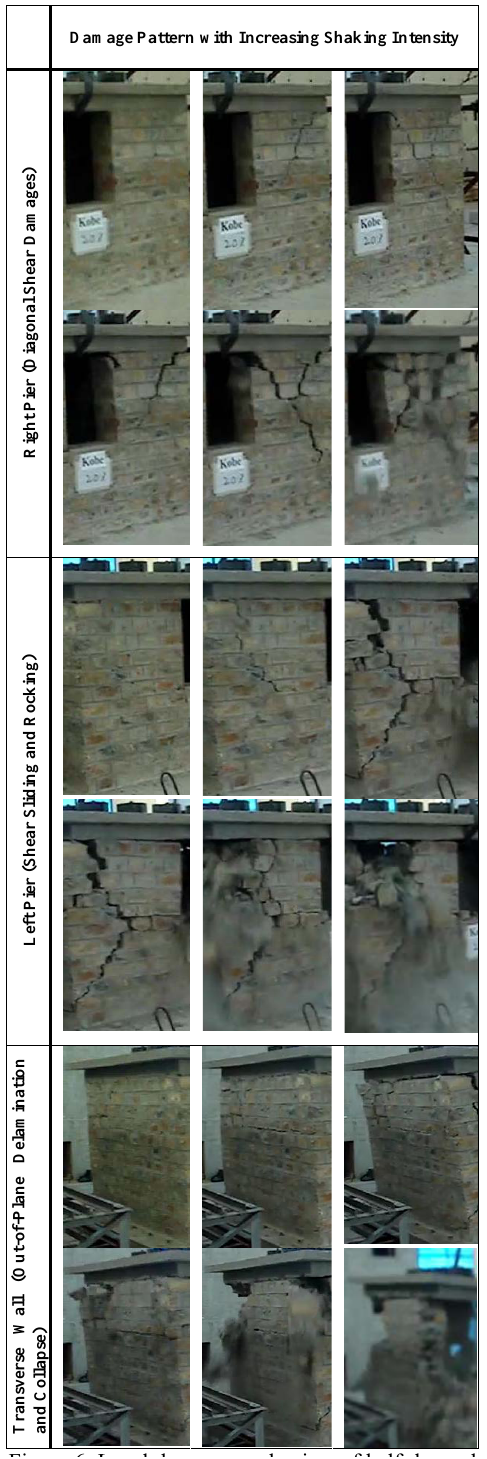
Figure 6. Local damage mechanism of half-dressed stone DS masonry walls observed during shake Fig. 6. Local damage mechanism of half-dressed stone DS masonry table test. From top to bottom: damages observed walls observed during shake table test. From top to bottom: damages in in-plane and out-of-plane walls. observed in in-plane and out-of-plane walls.